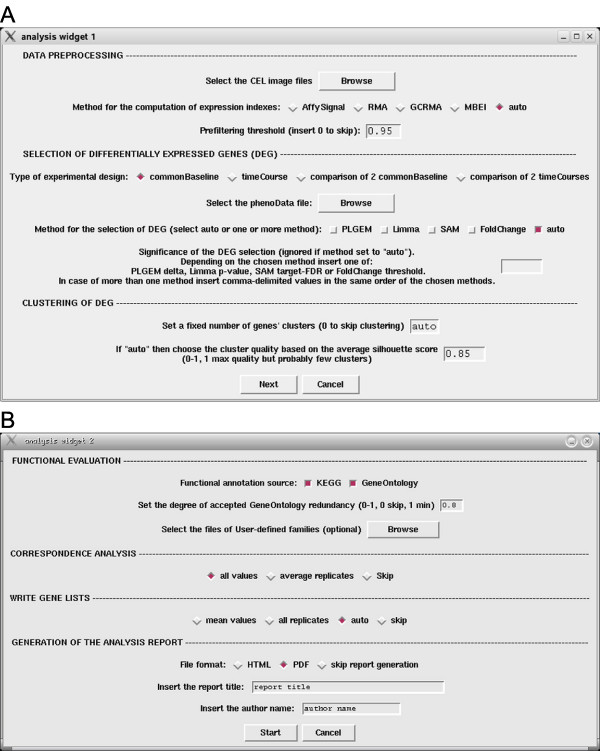
The advanced analysis widgets. Two widgets prompt the necessary information to run a complete analysis. These also allow the tuning of almost all the modifiable parameters of the tools available in the pipeline. Note that, when the auto option is available, there is the possibility to let AMDA decide the most appropriate setting. Basically the two widgets cover the loading and low level analysis of starting data, the selection of differentially expressed genes, their clustering (A), functional evaluation, correspondence analysis and setting of options on writing of gene lists and report files (B).